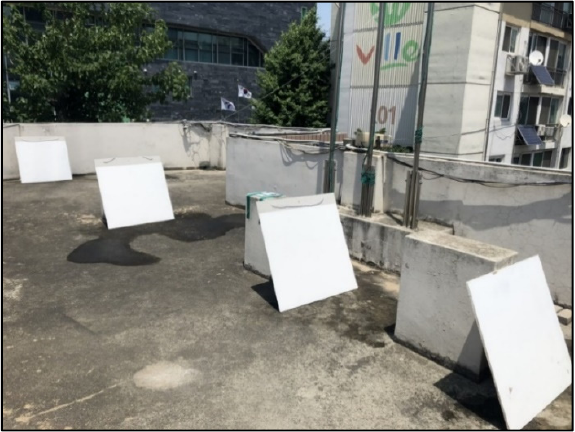
Figure 11. Specimens placed on the rooftop of the apartment.